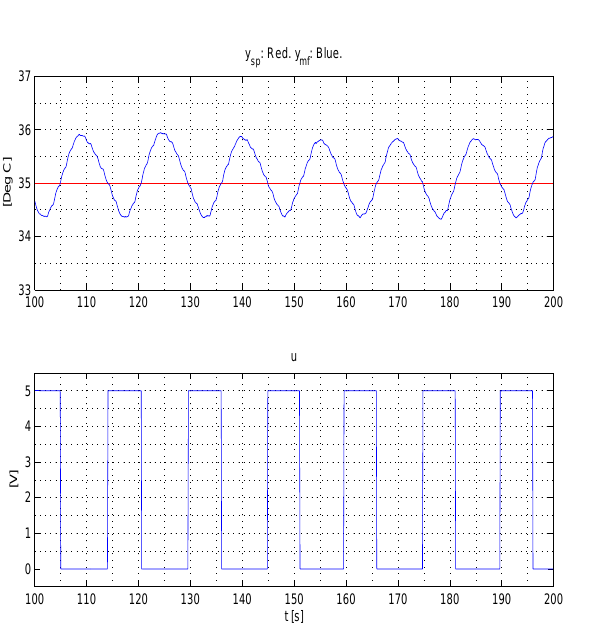
Figure 9: Responses with Ziegler-Nichols PI settings T r : ZN is clearly best. It gives fast control. R-ZN with k r = 1 is also relatively